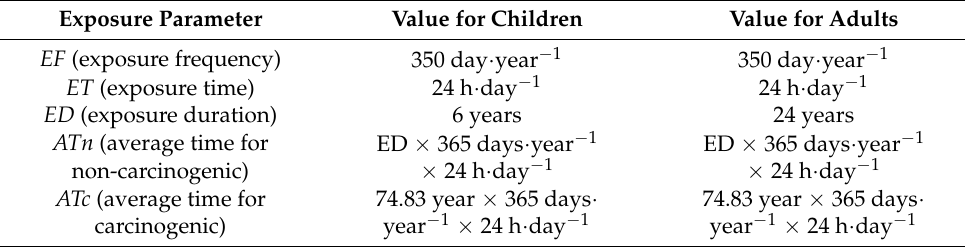
Table 3. Exposure parameters [43] of health risk assessment.